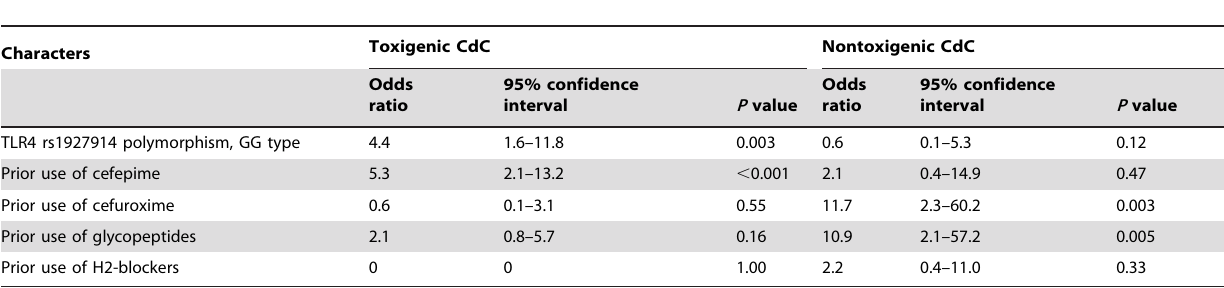
Table 4. Multivariate analysis of risk factors for fecal toxigenic or non-toxigenic Clostridium difficile colonization (CdC) during hospitalization among 347 patients. without CdC at